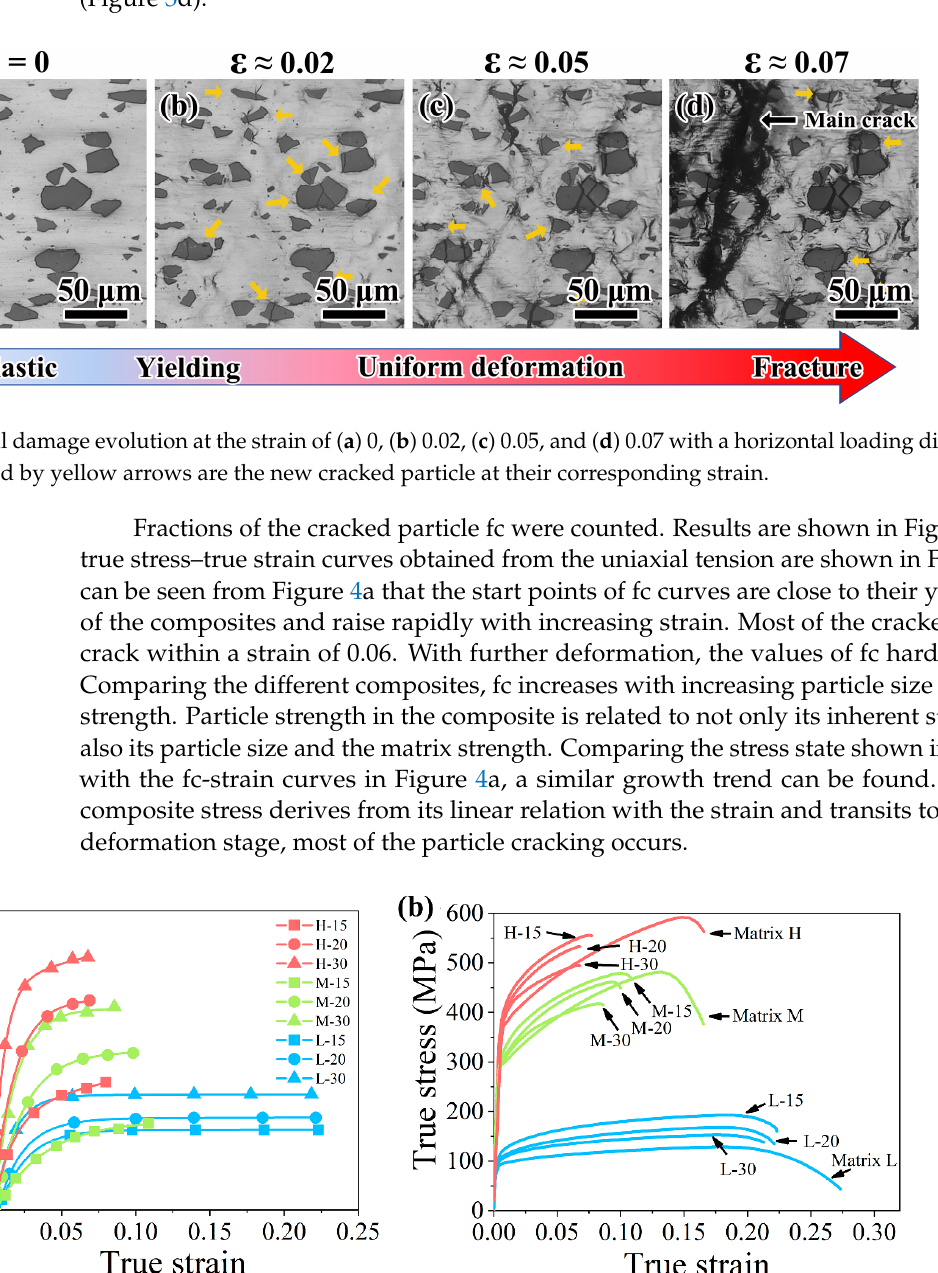
Figure 2. The yield strength (YS), ultimate strength (UTS), and elongation (EL) of the composites with ( a ) matrix L, ( b ) matrix M, and ( c ) matrix H. The mechanical properties of 0 μm particle represents the mechanical properties of the ma- trix.